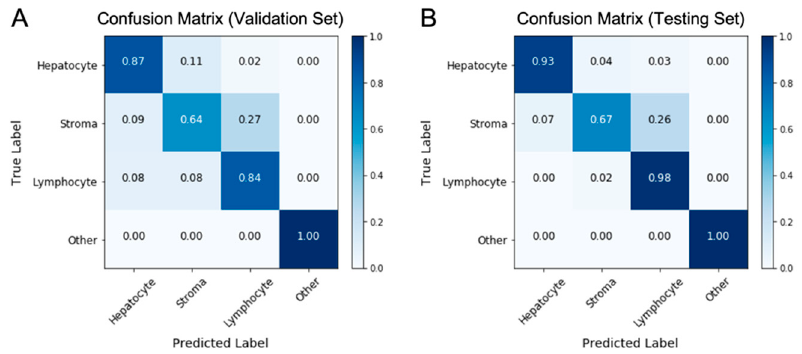
Figure 3. The HD-Staining model for nuclei segmentation and classification on hepatic H&E images. The performance of the HD-Staining model is shown by the confusion matrices between the predicted label and true label in the validation set ( A ) and testing set ( B ). The classification accuracies of the macrophage nuclei, red blood cells, and karyorrhexis are included in the “other” category of the confusion matrices.